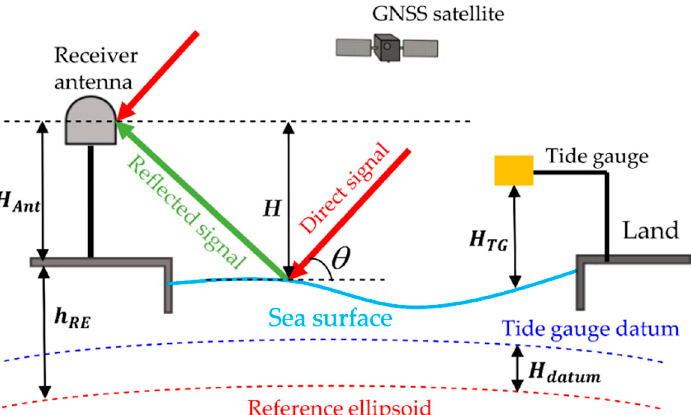
Figure 4. Simplified geometric chart of shore-based GNSS-IR sea surface altimetry. H is the reflector height between the antenna center and sea surface; H Ant is the vertical height from the antenna center and land surface; H TG is the tidal dataset collected from the tide gauge; H Datum is the difference between the reference ellipsoid and tide gauge datum; and 𝜃 is the satellite elevation angle.